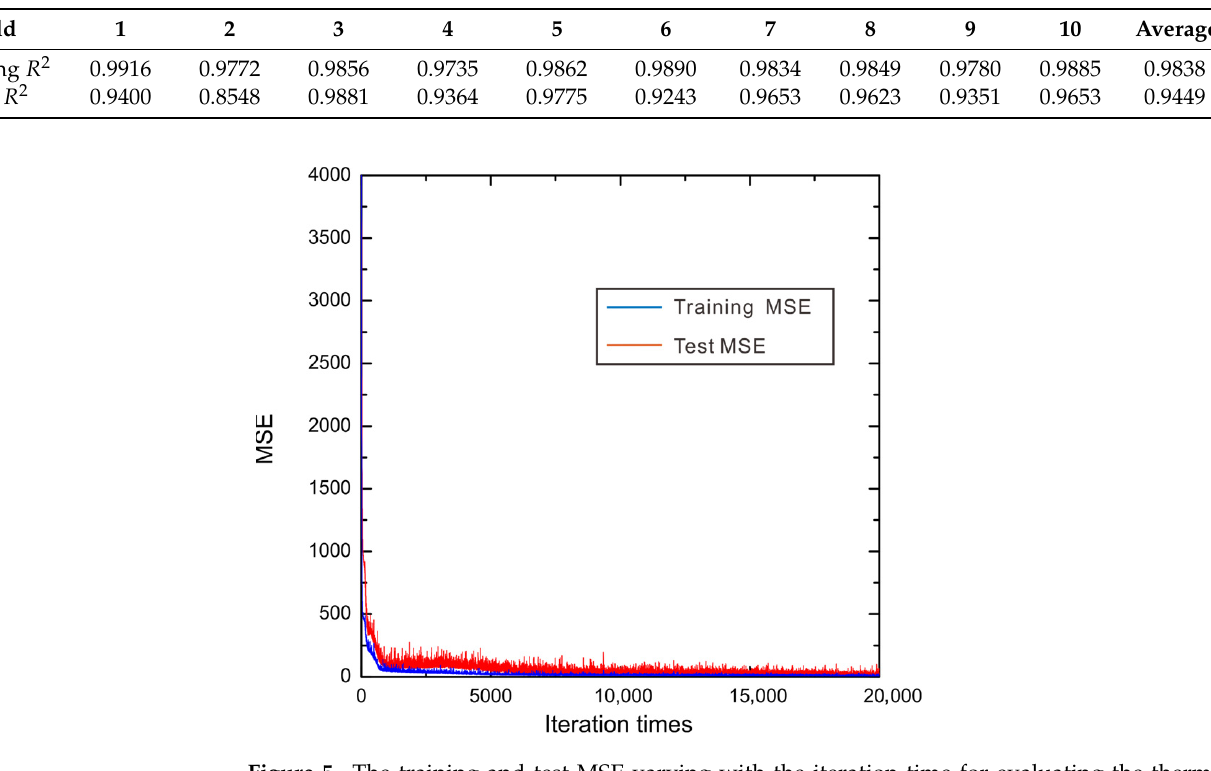
Figure 5. The training and test MSE varying with the iteration time for evaluating the thermal conductivity for WC-Co system.